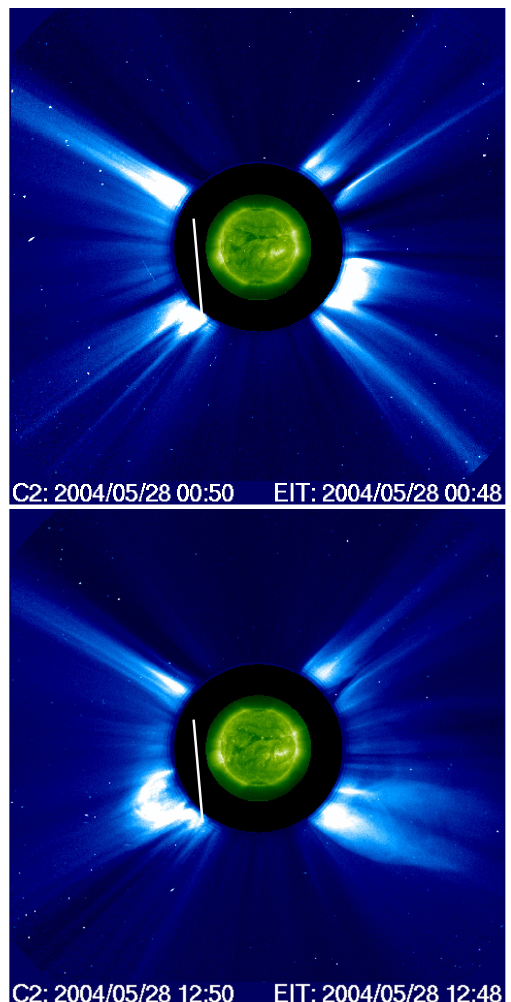
Fig. 1. Composite C2-EIT images of the corona: top, LASCO C2 image taken on 28 May 2004, at 00:50UT, prior to the CME analysed in this paper; bottom, C2 image taken at 12:50UT, about two hours after the CME initiation. EIT 195 ˚A maps are shown at approximately the same times. The position of the UVCS slit is given in the images as a white bar, set normal to the radius of the Sun through a southern latitude of 4.8 ◦ , at an altitude of 1.55 R (cid:12) , in the eastern